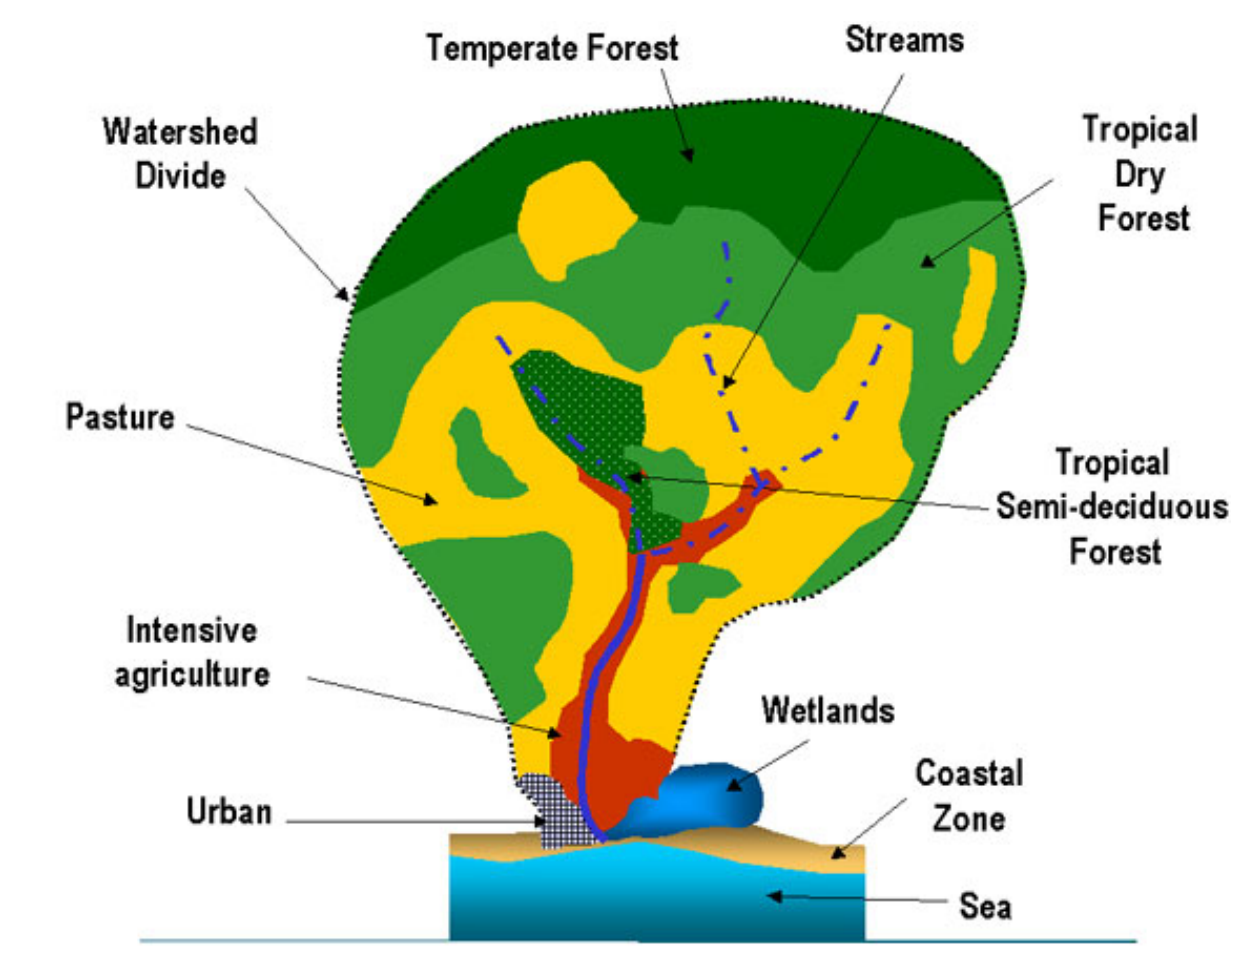
Fig. 3. Basin conceptual model showing the socioecological units derived from the biophysical and social constraints, and the drivers controlling human - ecosystem relationships in a tropical dry forest region of western